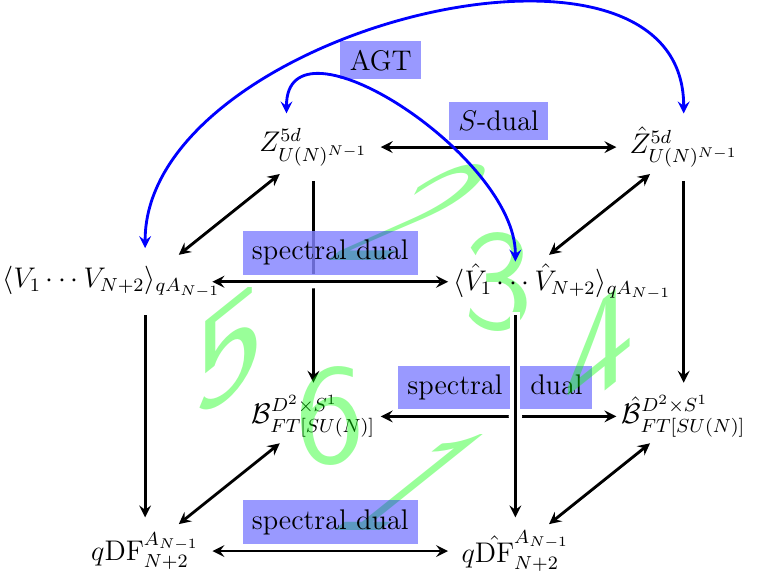
Figure 2 . Duality web II incorporates duality web I (face 1 of the cube) in a more general context of 3 d -5 d -CFT